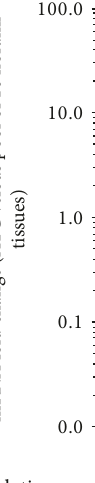
Figure 2: Relative expression levels of the PD-L1 , PD-L2 , CD80 , and CD86 mRNAs in ATC tissues. The fold changes were calculated considering the mRNA values of a pool of 10 normal thyroid tissues equal to one. The small bars in the graph indicate the median values. Table 2: Correlation among the expression levels of PD-1 and CTLA-4